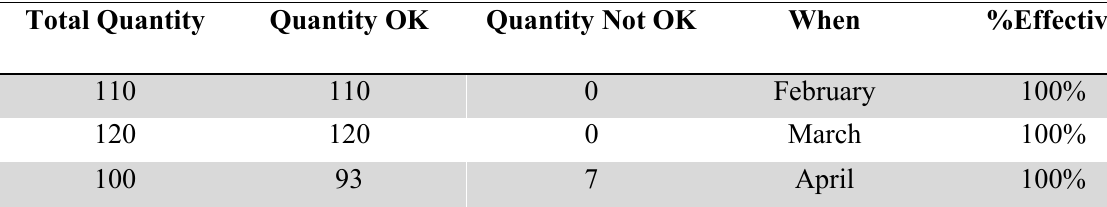
Fig. 1. NG/Good Parts and their Corresponding Grain Images Interim Corrective Action